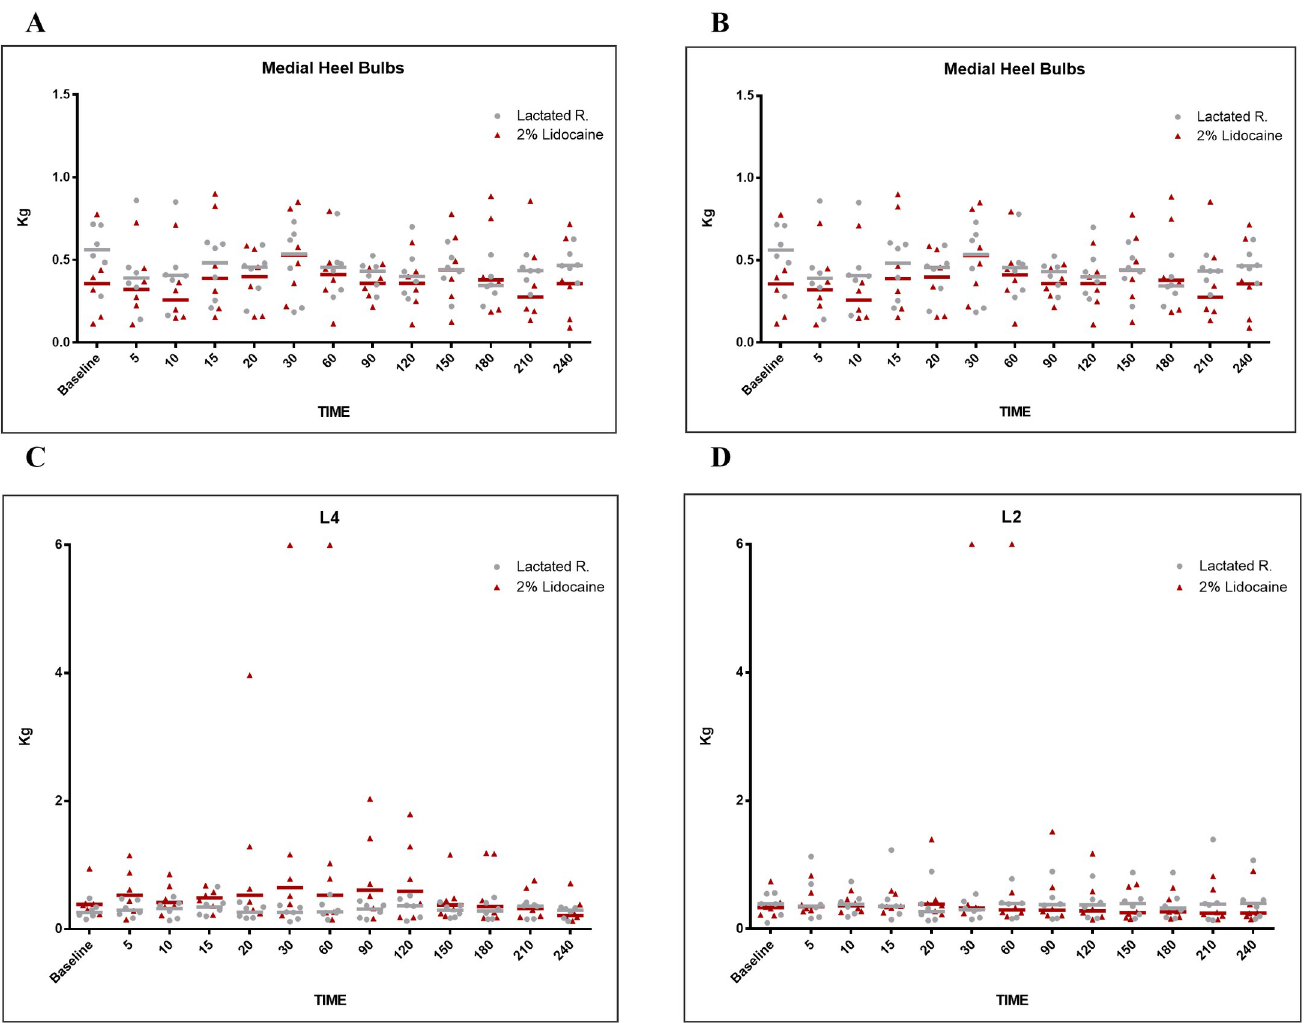
Fig 3. Graphical representation of mechanical nociceptive threshold (MNT) values, with mean values and median in kilograms (kg). Evaluation of heel bulbs: (A) medial, (B) lateral. Evaluation of dorsal lamellar regions (L): (C) L2 cm, and (D) L 4 cm, distal to the coronary band of hooves in healthy equine forelimbs, injected into navicular bursa with lactated Ringer’s solution or 2%